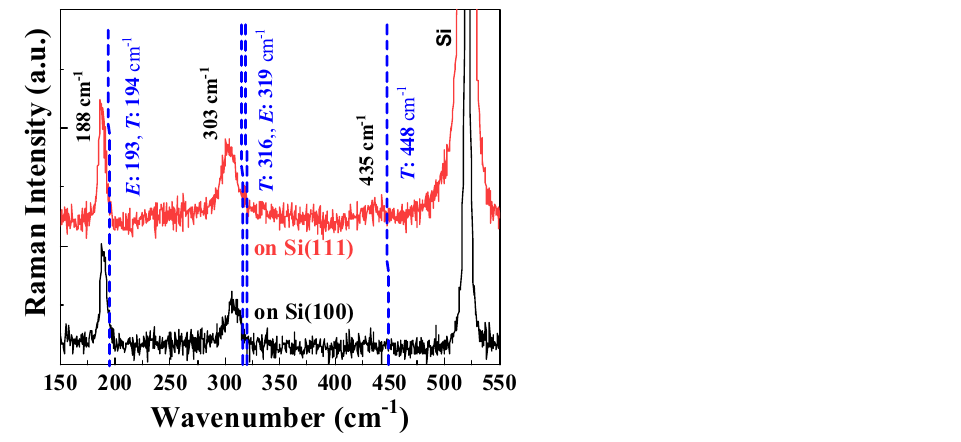
Figure 5. Representative room-temperature Raman spectra for different samples on Si(100) (black) and (111) (red) substrates. One spectrum is vertically shifted for better visibility. For both samples, the Raman modes shift to lower wavenumbers. The known Raman frequencies (in cm −1 ) of ( E , T ) modes for bulk MnSi are indicated by the dash lines (blue) in the figure for